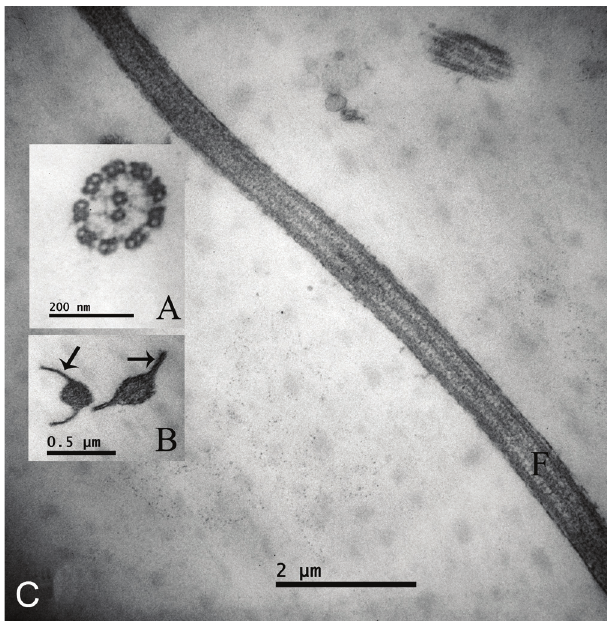
Fig. 3. Transmission electron microscopy photographs of the flagellum. (A) Flagellum axoneme showing the typical 9+2 dou- blets of microtubules. (B) Transversal section of the flagellum showing the lateral extensions like “fins” in both sides (arrows). (C) Longitudinal section of the flagellum. F: Flagellum.